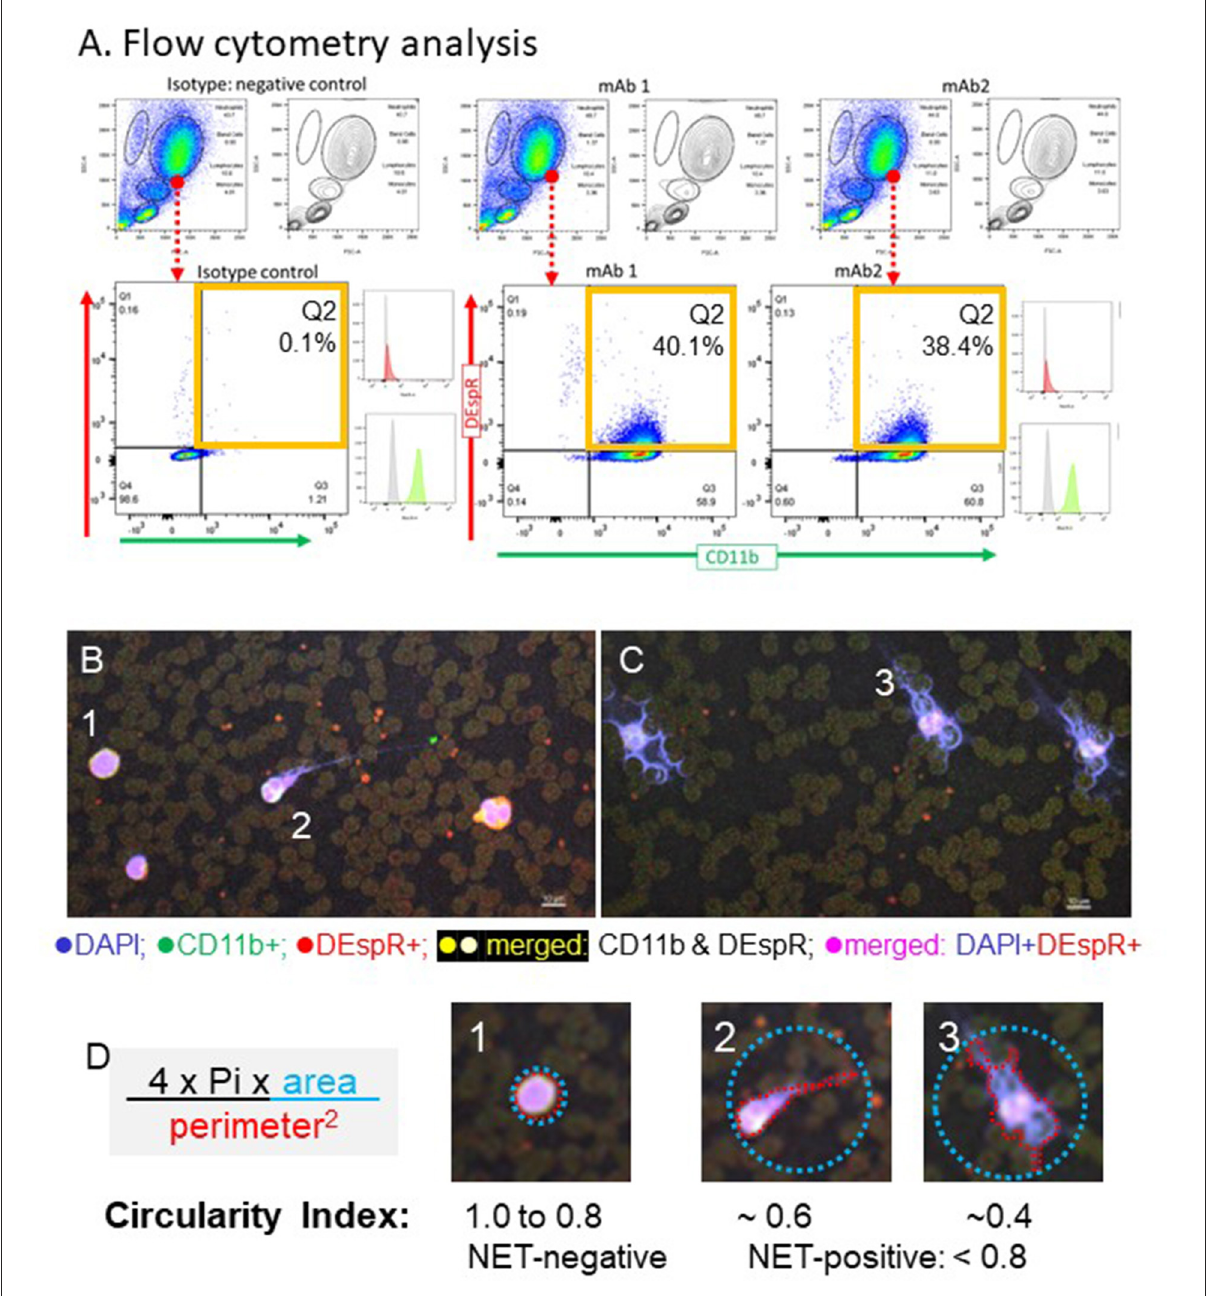
FIGURE1 Representative images of identification of DEspR + CD11b + “rogue” neutrophils by flow cytometry and neutrophil extracellular trap (NET)-forming neutrophils by immuno-cytology in patients with spontaneous intracerebral hemorrhage (sICH) whole blood. (A) Representative flow cytometry (FCM) analysis, done in duplicates, of DEspR + CD11b + neutrophils (Ns) of the first sICH consented subject. Top row: FSC, forward side scatter (size), SSC, side scatter (granularity), → encircled neutrophil cloud identified on a dot plot, corroborated on contour plot, and distinguished from monocytes and lymphocytes. Isotype controls for both antibody probes vs. double immunotyping with anti-DEspR (hu6g8)-AF647 and anti-CD11b-AF488. (cid:3) Quadrant 2 (Q2) for DEspR + CD11b + neutrophils. Mean fluorescence intensity (MFI) histograms shown: isotype (cid:4) , hu6g8 (cid:4) , and CD11b (cid:4) . (B) Representative images of immunofluorescence (IF)-stained peripheral blood smears from a patient survivor with sICH and (C) non-survivor on day of flow cytometry analysis. DEspR + CD11b + NET-forming neutrophils with still intact cell membranes are noted in both. NET-forming neutrophil extruded DNA wrapped around red blood cells (RBCs) noted predominantly in sICH non-survivors. Bar = 10 µ m. (D) Quantitation of intravascular NET-formation using shape analysis circularity index formula: 4 * Pi * area of the smallest circle that encompasses the whole NET-forming neutrophil divided by perimeter-squared of the traced outline of the DAPI-stained DNA extruded from the neutrophil with the still intact cell membrane. Panels #1: example of non-NET-forming neutrophil with circularity index 1.0; #2: NET-forming neutrophil with circularity index ∼ 0.6; #3: NET-forming neutrophil with circularity index ∼ 0.4. For quantitation: NET-negative: circularity index 0.8 to 1.0; NET-positive: circularity index < 0.8. Automated imaging and quantitation